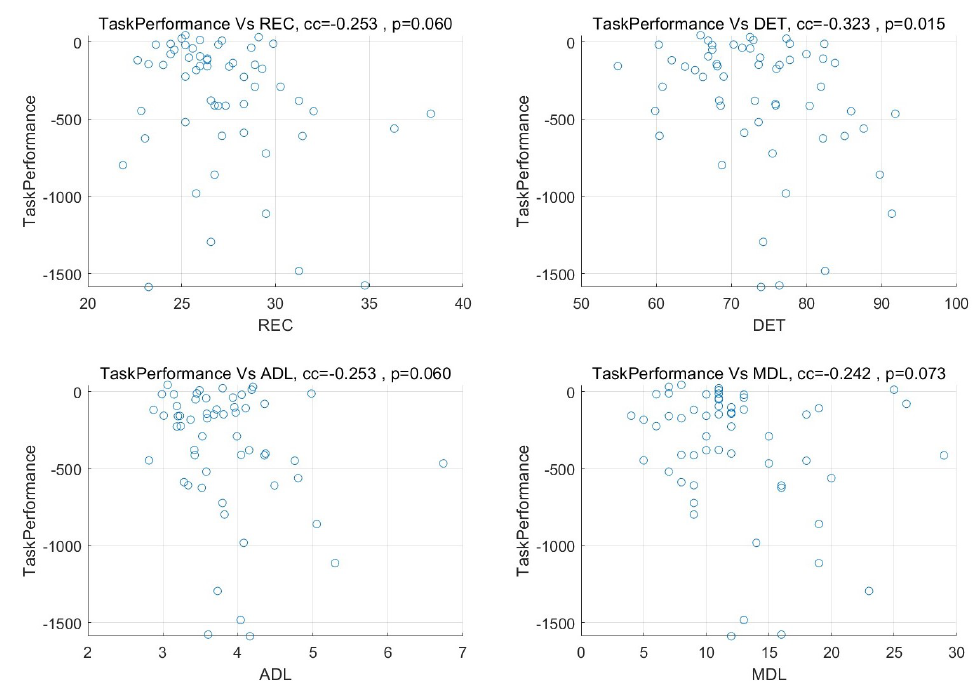
Figure 5. The scatter plot for MdRQA measures and task performance for